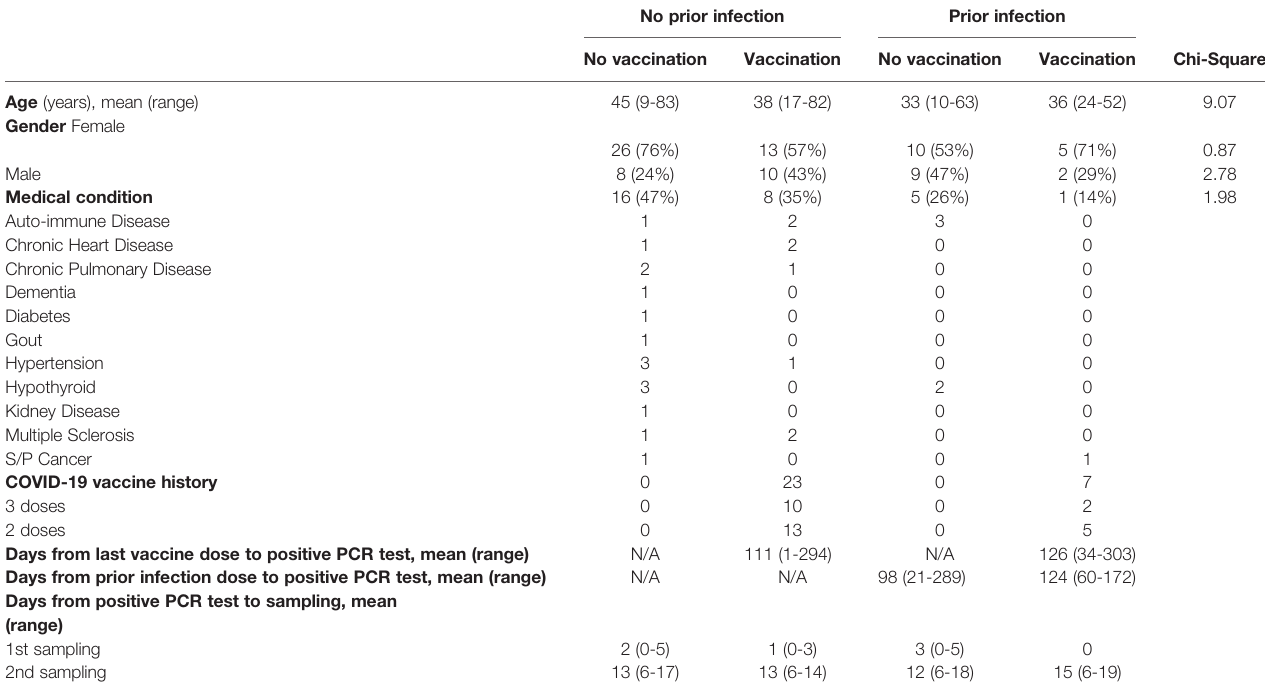
TABLE 1 | Characteristics of Omicron study